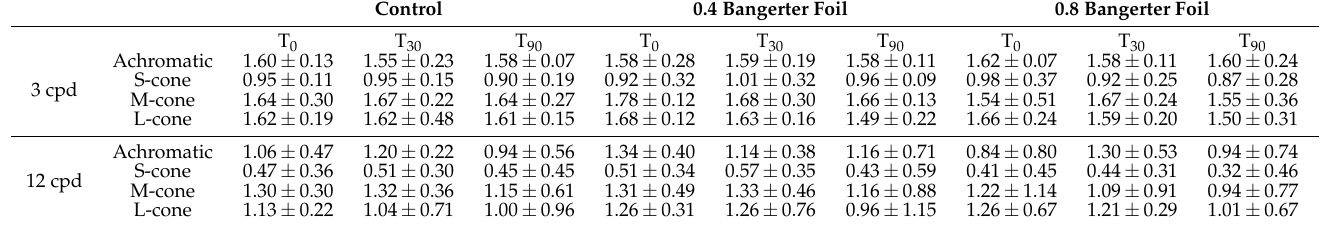
Table 1. Log(CS) (median ± IQR) for the different measurement conditions ( n =19 participants). Control